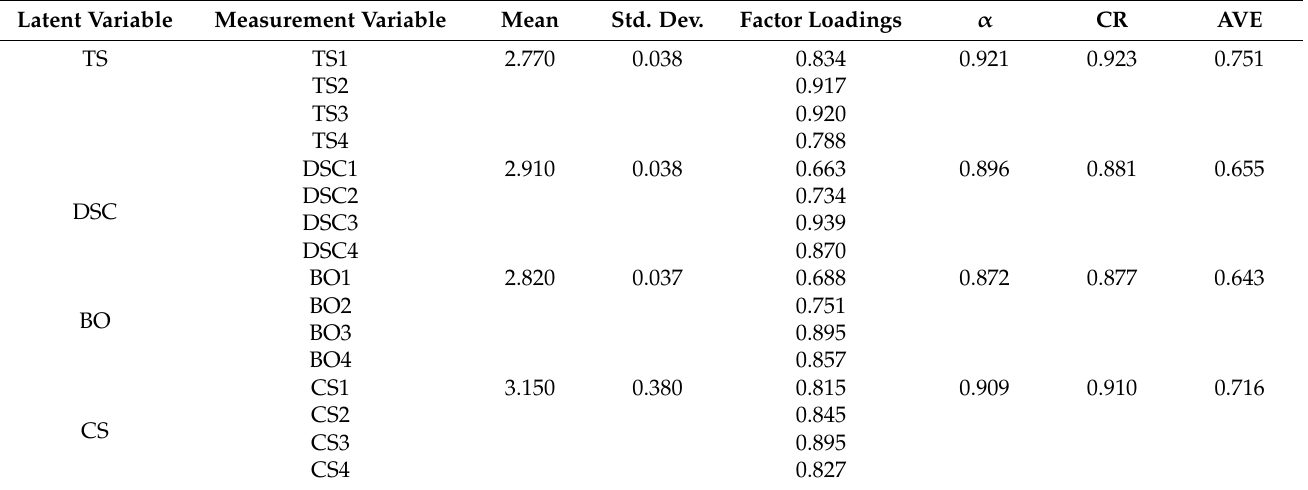
Table 2. Results of the Confirmatory Factor Analysis.